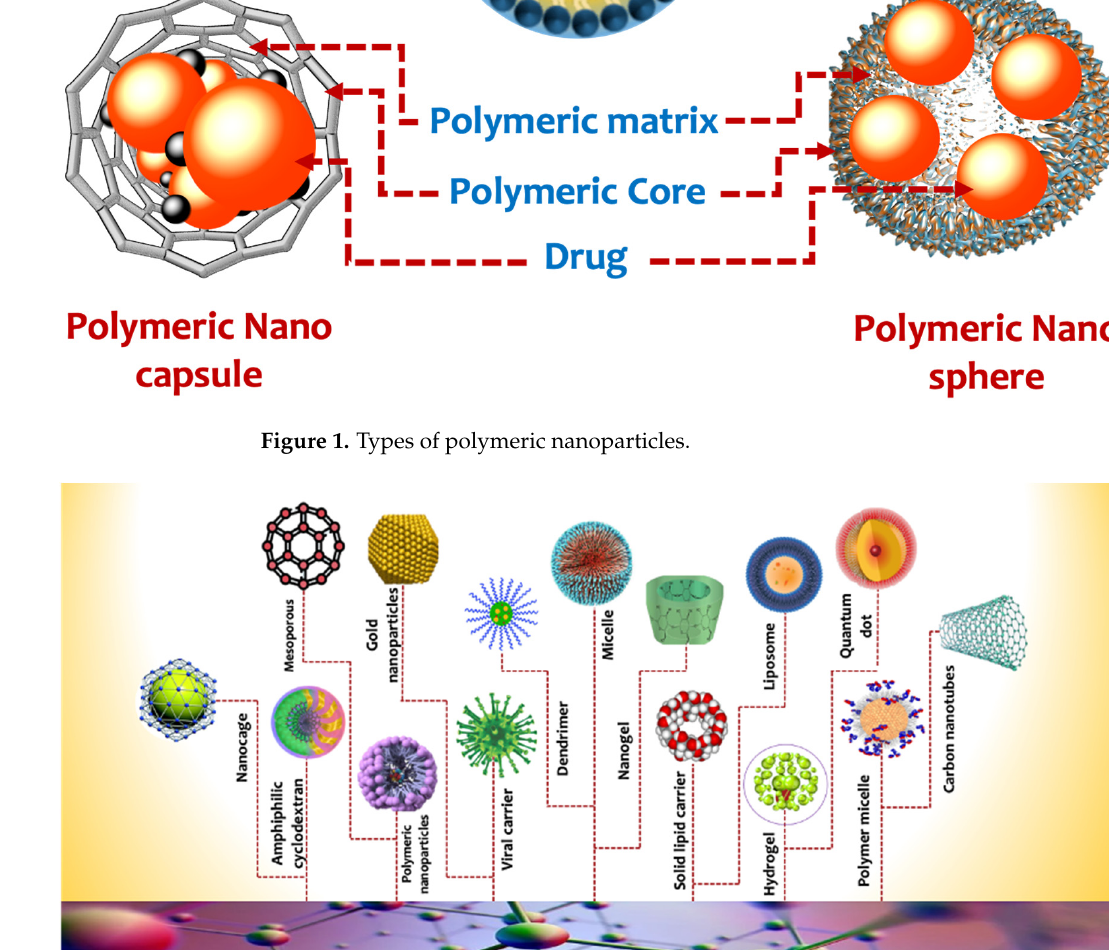
Figure 2. Different types of nanocarriers.